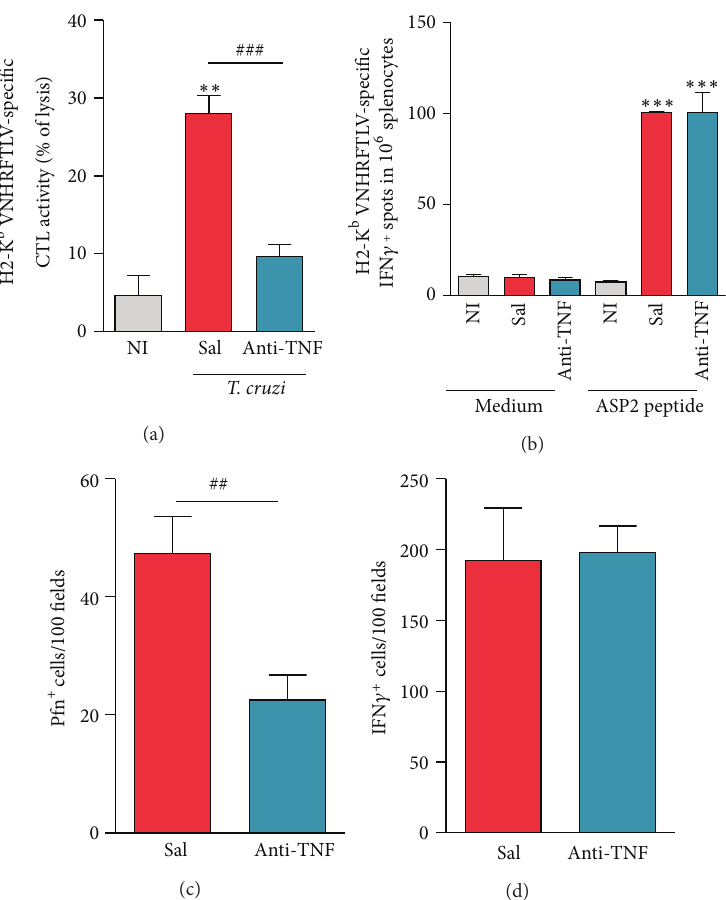
Figure 6: Anti-TNF therapy reshapes Trypanosoma cruzi -specific CTL activity and IFN 𝛾 -producing cells in spleen and the composition of Pfn + and IFN 𝛾 + cells invading the cardiac tissue in chronically Trypanosoma cruzi -infected mice. C57BL/6 mice infected with 100bt of the Colombian T. cruzi strain were treated from 120 to 150 dpi and analyzed at 150 dpi. (a) Frequency of in vivo specific lysis of H-2K b -restricted VNHRFTLV ASP2 peptide-labeled target cells in spleen. (b) Numbers of H-2K b -restricted VNHRFTLV ASP2 peptide IFN 𝛾 + cells (spots) among splenocytes. Immunohistochemical staining of (c) Pfn + and (d) IFN 𝛾 + cells infiltrating the cardiac tissue, at 150dpi. ∗∗ 𝑃 < 0.01 and ∗∗∗ 𝑃 < 0.001 , T. cruzi -infected mice (saline injected or anti-TNF treated) compared to NI controls. ## 𝑃 < 0.01 and ### 𝑃 < 0.001 , anti- TNF-treated compared to saline-injected T. cruzi -infected mice. Bar represents the mean ± SD of the studied group (3 to 6 mice). These data represent three independent